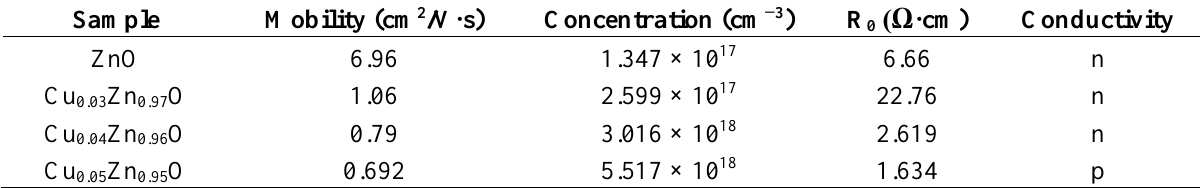
Table 1. Hall effect measurements of CuZnO (CZO) thin